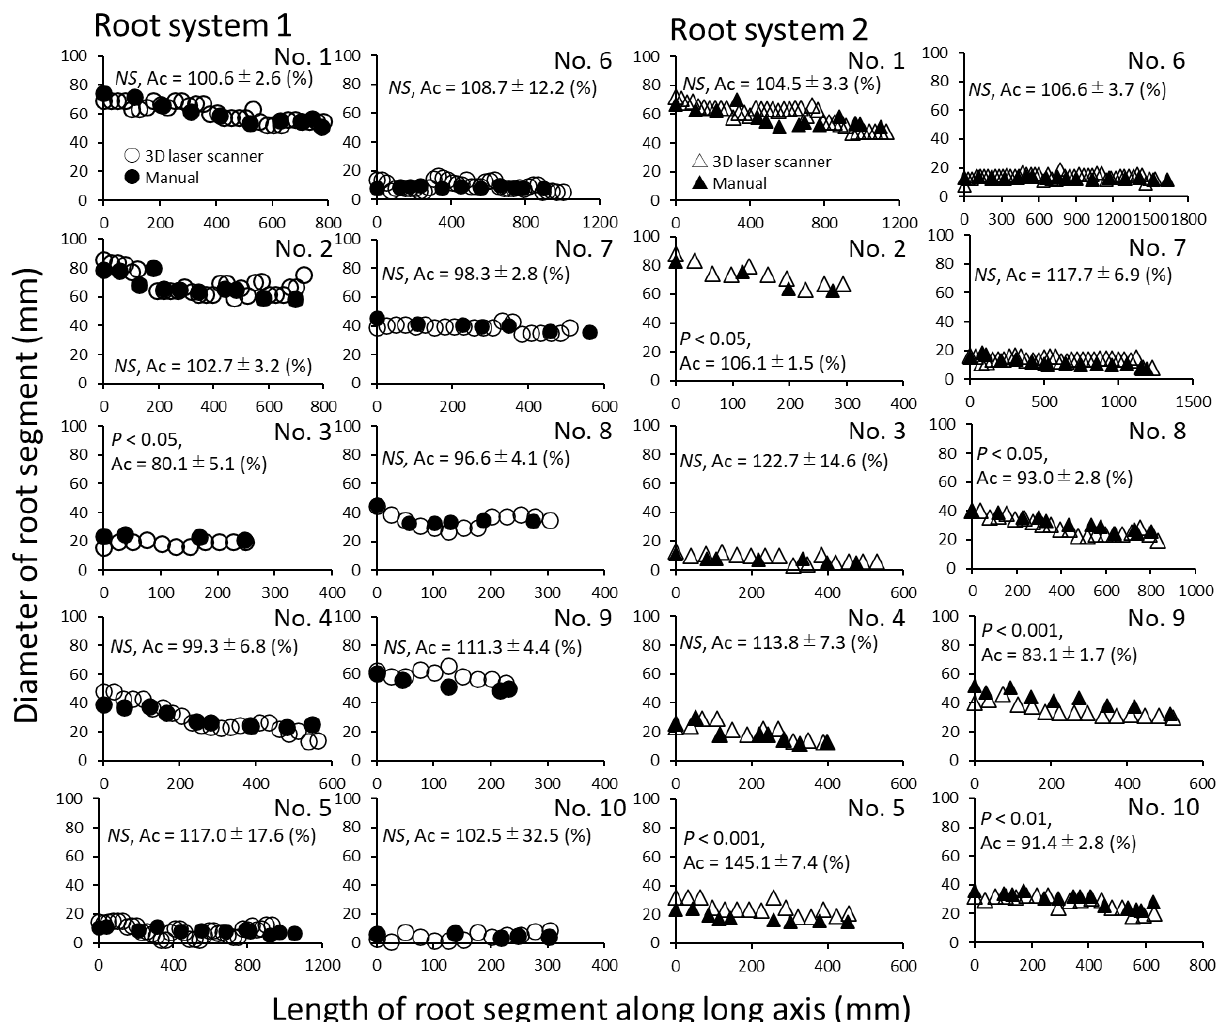
Figure 8. Changes in the diameters of 10 root segments along the long axis in each root system by 3D laser scanner and manual measurements. A paired t -test was used to compare the differences in the diameters of 10 root segments along the long axis data obtained by the manual measurement with those obtained by the 3D laser scanner. NS: not significant ( p > 0.05). The correlation coefficient (r) was calculated as the mean value estimated by 1000 bootstraps. The accuracy (Ac, mean ± standard error) of the diameter at 10 root segments in each root system was defined as the percentage of the diameter estimated by the 3D laser scanner to that of the manual measurement according to Lau et al. [27].